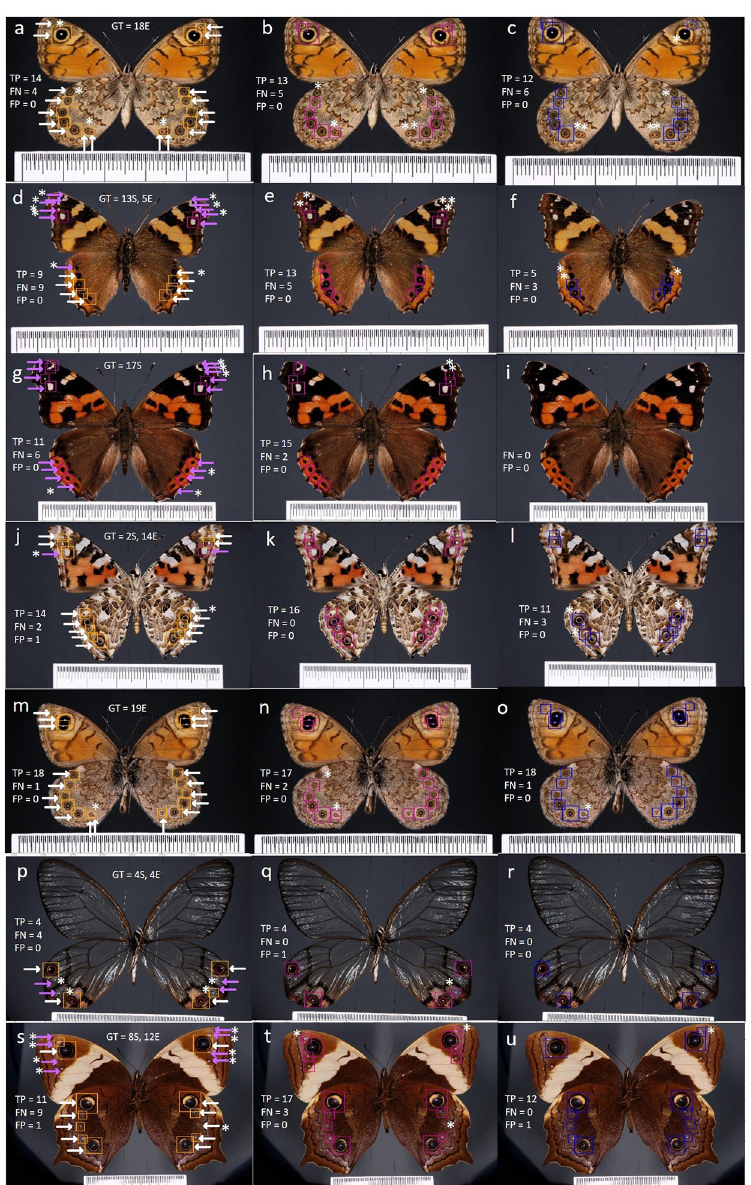
Fig 6. RetinaNet detection examples. Left column shows detections of the two-class model (spots in pink and eyespots in orange), middle column shows detections of one-class (no distinction between spot or eyespot types) and right column shows detections of “Marginal eyespots only” RetinaNet. The first image in a row is annotated for the ground truth (GT) in terms of total number of spots (S) and eyespots (E), with eyespots marked with white arrows, and spots with pink arrows. In the other images we score the true positives (TP), the false negatives (FN) and the false positives (FP) and we add an asterisk ( � ) next to the undetected or misclassified pattern elements.